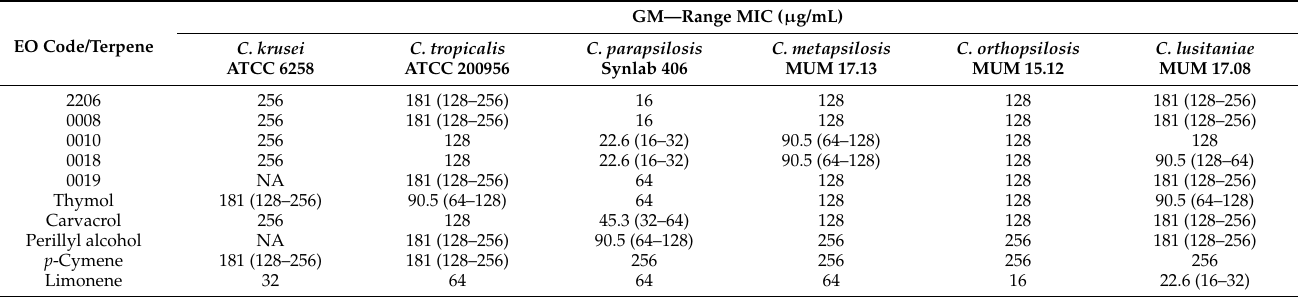
Figure 1. Results of screening the in vitro activity of EOs and some commercial terpenes against different Candida species. The presence of the bar indicates antifungal activity at 256 µg/mL. For the most active EOs and commercial terpenes, minimal inhibitory concentrations (MICs) were determined. Important results were observed with the resistant strains C. tropicalis ATCC 200956 and C. parapsilosis Synlab 406. MIC values for non- C. auris species are shown in Table 3. Table 3. Minimal inhibitory concentration values of the most active EOs studied and of some commercial terpenes against non- C. auris species.